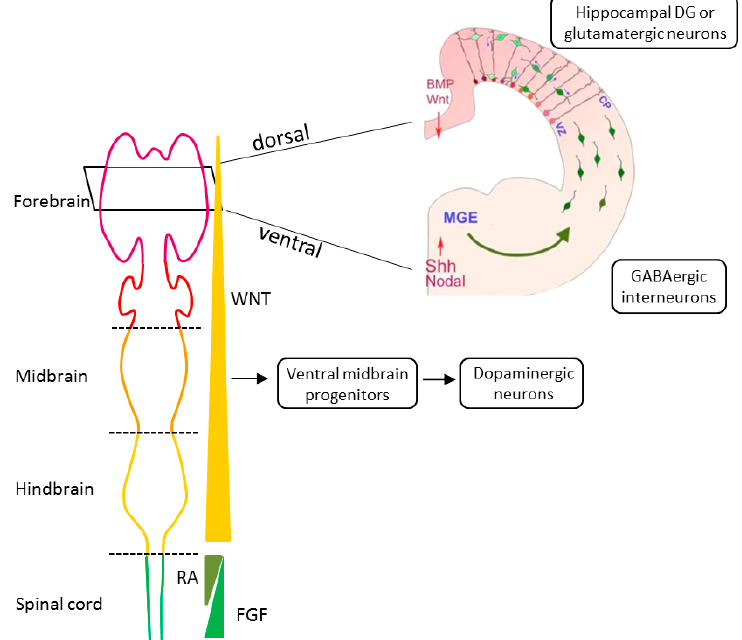
Figure 1. Tracing early neurodevelopment. Key morphogens in anterior–posterior patterning are WNT (wingless), FGF (fibroblast growth factors), and RA (retinoid acid). Gradients of these morphogens regulate differentiation into specific types of neural progenitor cells of forebrain (purple), midbrain (orange), hindbrain (yellow), and anterior spinal cord (green). Key morphogens in dorsal–ventral patterning are gradients of BMP (bone morphogenetic proteins), WNT, SHH (sonic hedgehog), and Nodal. BMP and WNT determine the dorsal fates of neural progenitor cells, whereas SHH and Nodal determines ventral fates. Different types of neural cells for tracing early neurodevelopment in schizophrenia (SCZ) are shown: Ventral midbrain progenitors give rise to tyrosine hydroxylase-positive dopaminergic neurons. Neural progenitor cells (green) from the ventricular zone (VZ) of the dorsal telencephalon generate all excitatory glutamatergic pyramidal neurons. Dorsal progenitors use radial glia cells (red) as